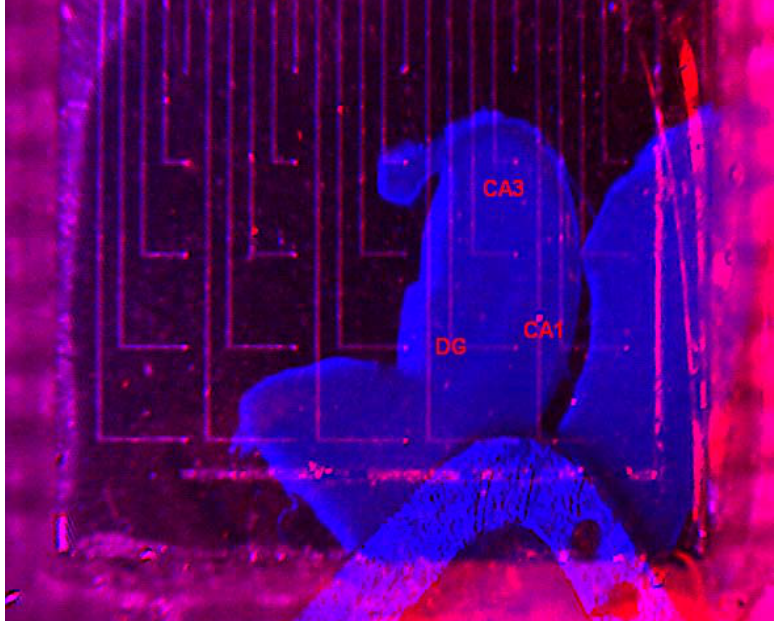
Figure 9. Synthesis image of a newborn rat (P18) 300- μ m hippocampal slice placed over the MEA, fixed with the miniature metallic horseshoe; several regions of interest are marked (DG – dentate gyrus, CA3 and CA1).